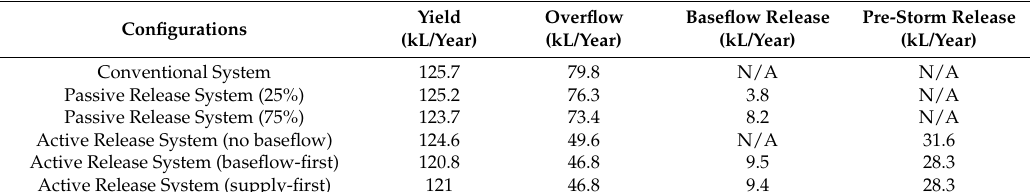
Table 4. Numeric example of system performance in different configurations. The scenario of this simulation is a 200 m 2 roof draining to 5 KL tank with all end uses connected. The baseflow release target set for the active release system is Q 25 (6.0 × 10 − 4 mm/6 min). All simulation results are listed in supplementary material S2.